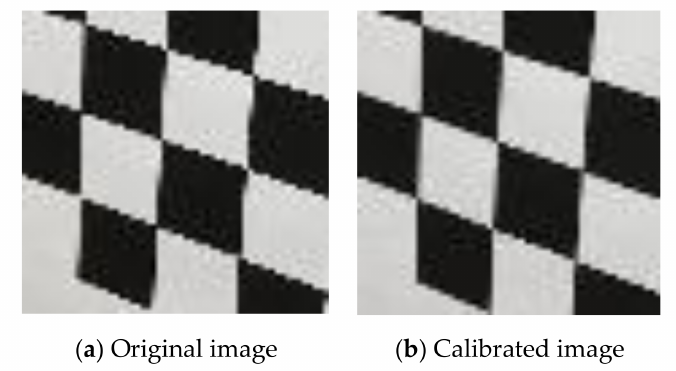
Figure 3. Pre- and post-calibration images of B&W